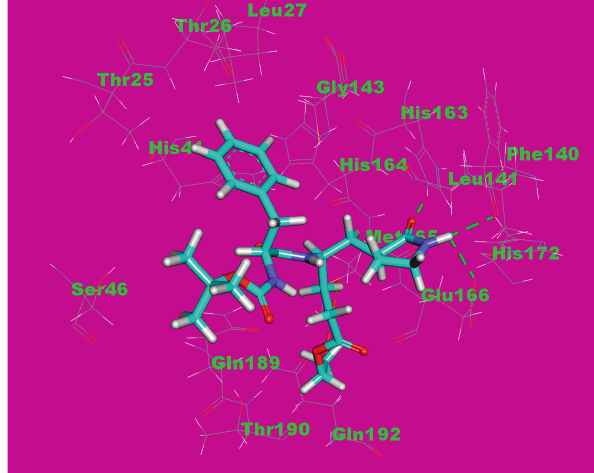
Figure 2: Cocrystallized ligand (PRD-002214) docked into the active site of the COVID-19 main protease. The hydrogen bonds are represented in green dashed lines, and the hydrophobic in- teractions are represented in orange dashed